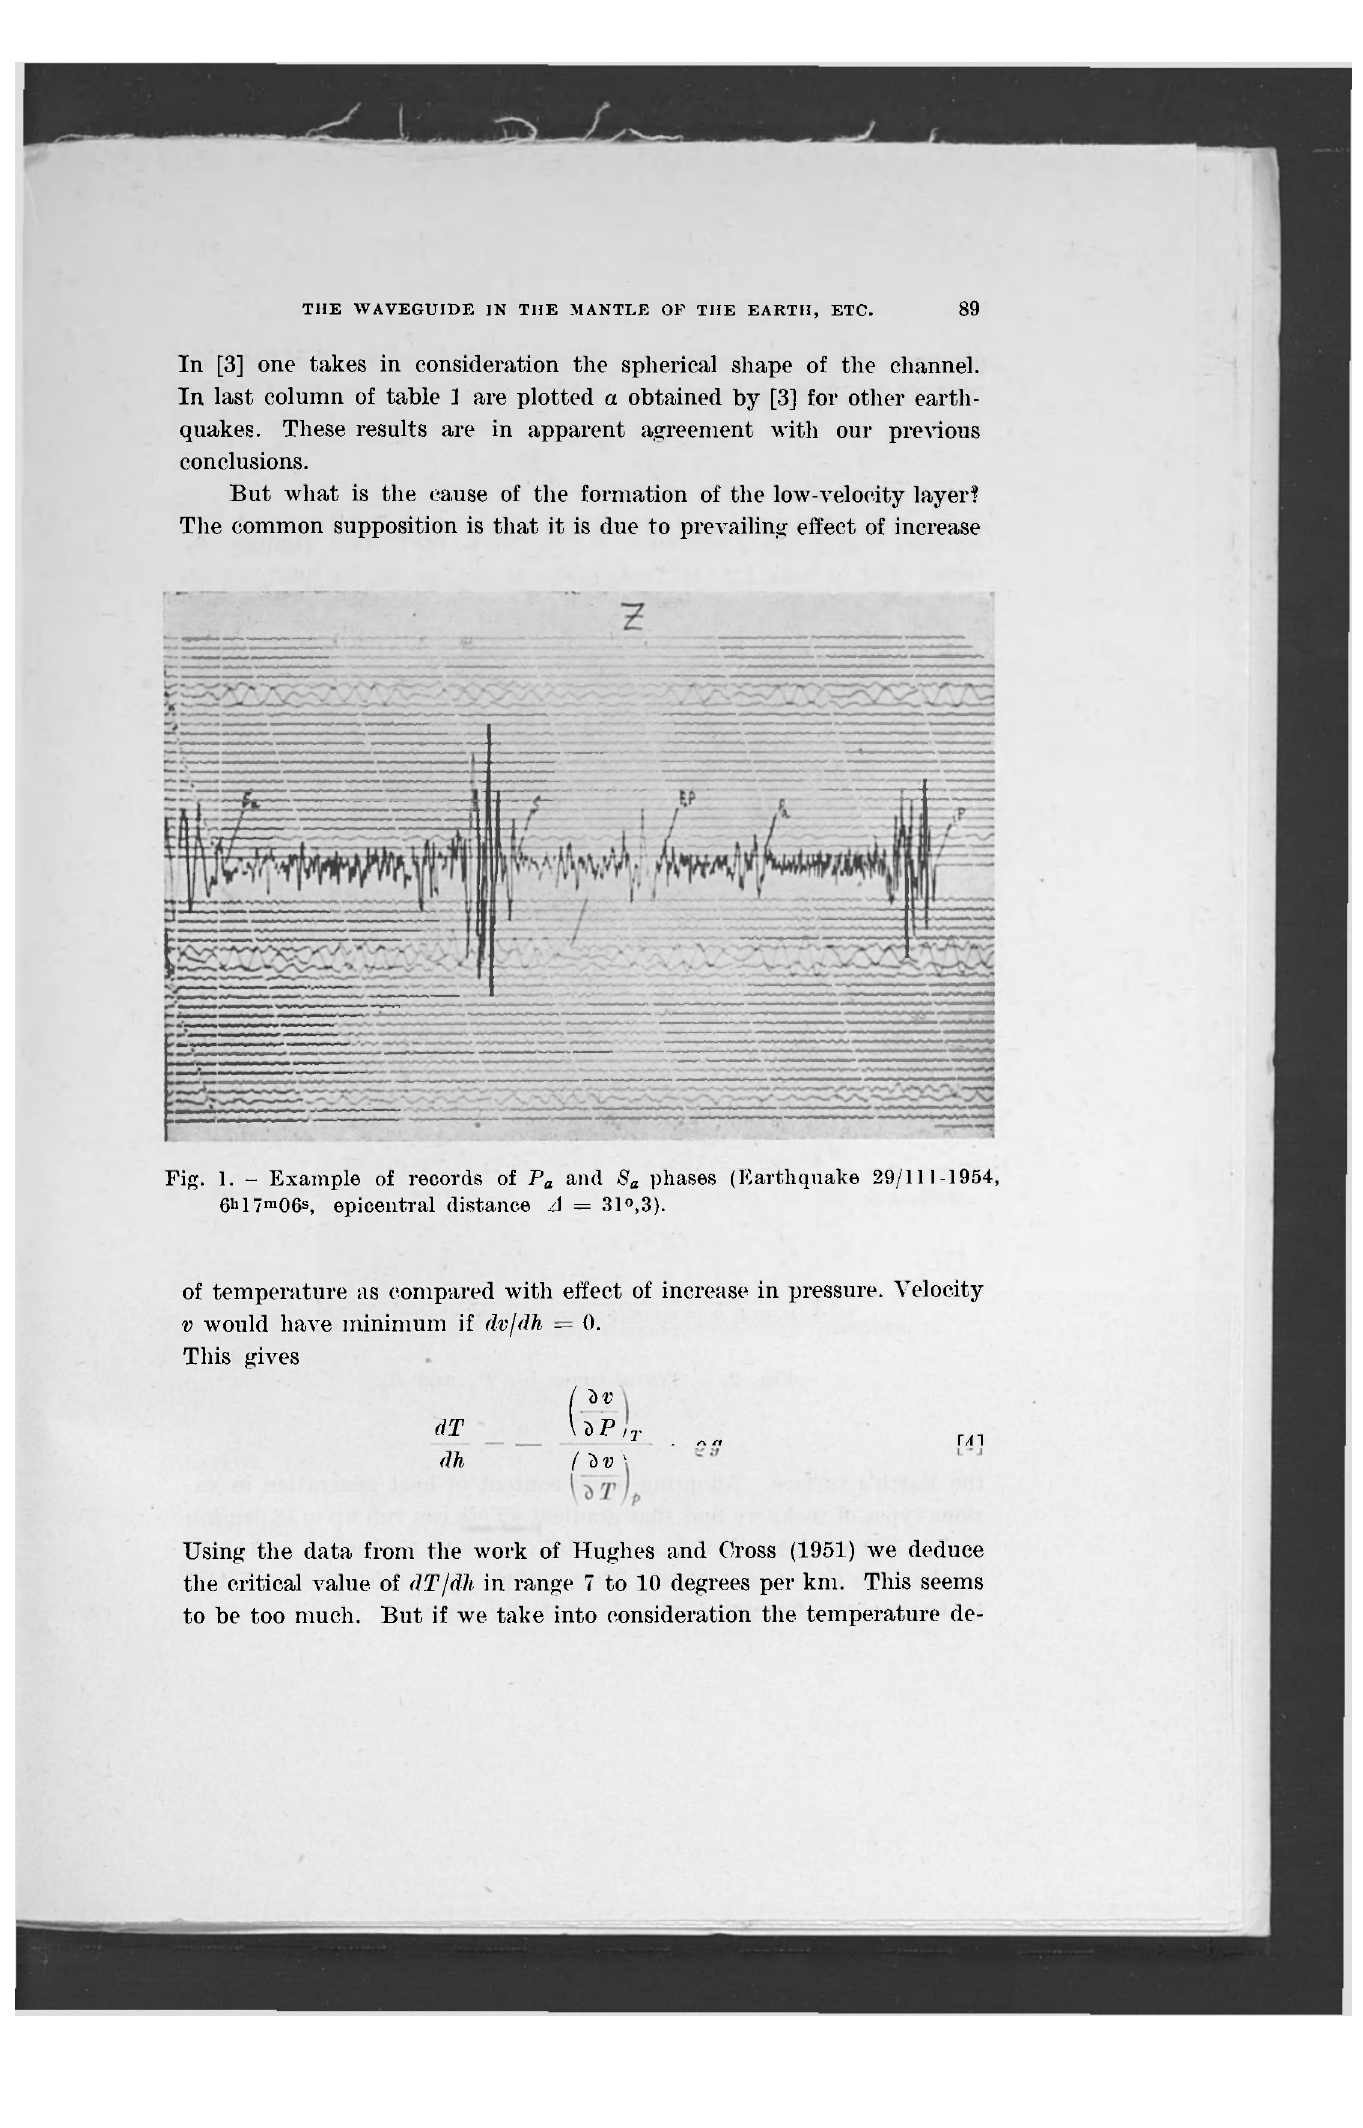
Fig. 1. - Example of records of P A and S A phases (Earthquake 29/111-1954, 6 h 17 m 06 s , epicentral distance A =